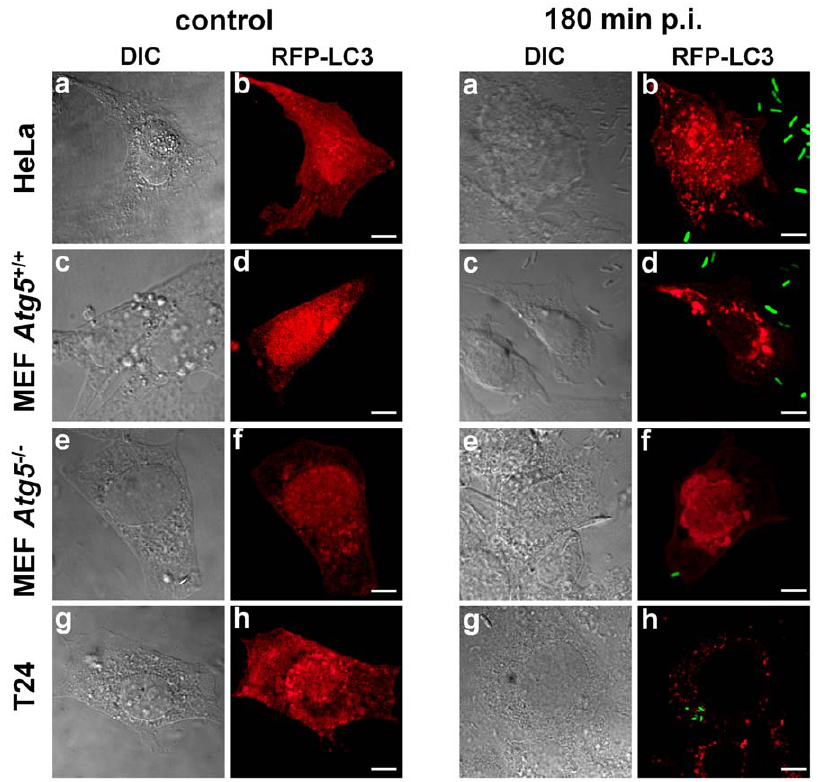
Figure 3. Serratia is able to induce autophagy in different epithelial cell lines. HeLa, MEFs Atg5 + / + , MEF Atg5 2 / 2 and T24 cells were transiently transfected with pRFP-LC3 (left panels, red fluorescence) and invaded with wild-type S. marcescens transformed with pGFP (right panels, green fluorescence). Cells were fixed at 180 min p.i. and visualized by confocal laser microscopy. Images are representative of at least 300 infected cells monitored in two independent assays. Bars: 10 m